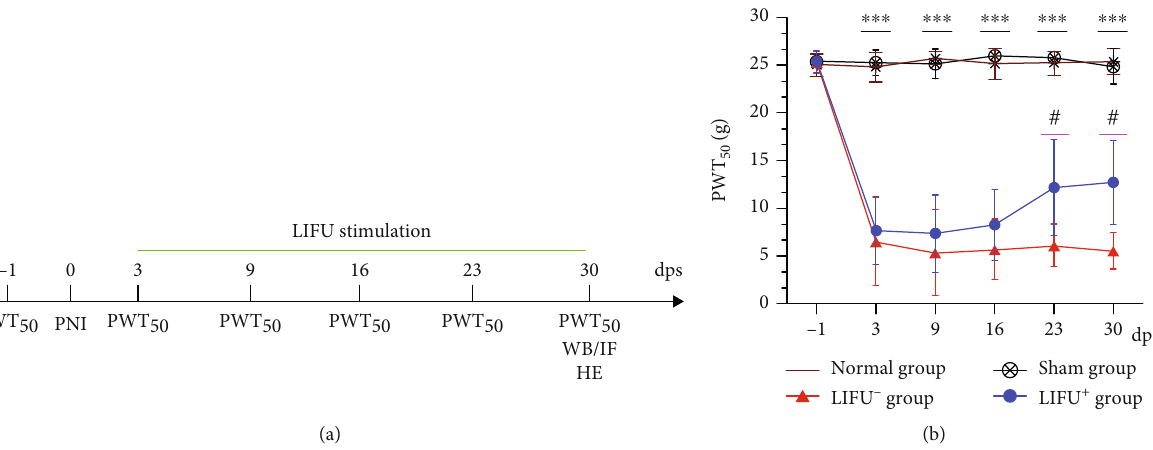
Figure 2: (a) Timeline of experimental protocol. Dps: days postsurgery. (b) Therapeutic e ff ects of LIFU stimulation on NP in PNI rats. Mechanical allodynia (PWT ) was signi fi cantly decreased in the LIFU − and LIFU + groups 3 days after PNI surgery compared with the 50 normal and sham groups. After 3 weeks of LIFU treatment, PWT increased compared with the LIFU − group. Each symbol represents 50 the mean ± SEM ; ∗∗∗ P < 0 : 001 against the LIFU − and LIFU + groups, # P < 0 : 05 against the LIFU − group. One-way ANOVA; n = 10 per